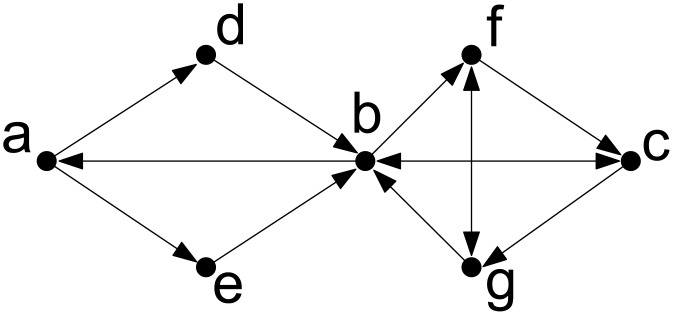
Edge connectivity in directed graphs.